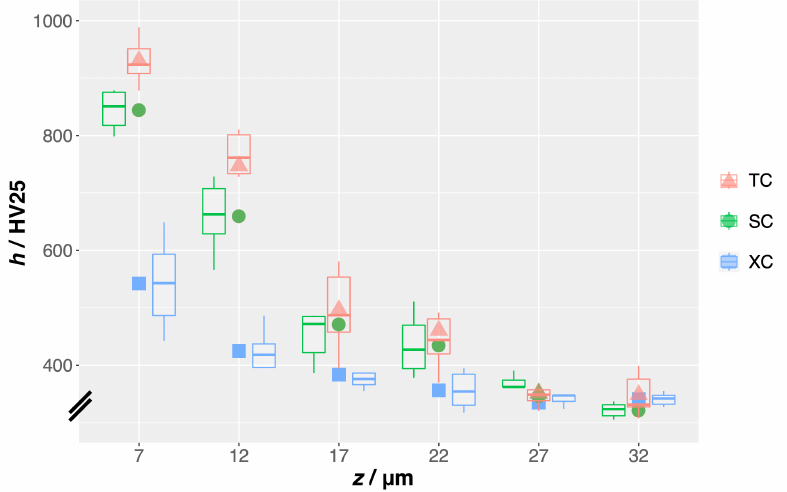
Figure 3. Hardness–depth profiles h [ z ] of low-temperature-carburized AISI-316L samples: XC , SC , and TC . The profiles were obtained using a Vickers indenter with a load of